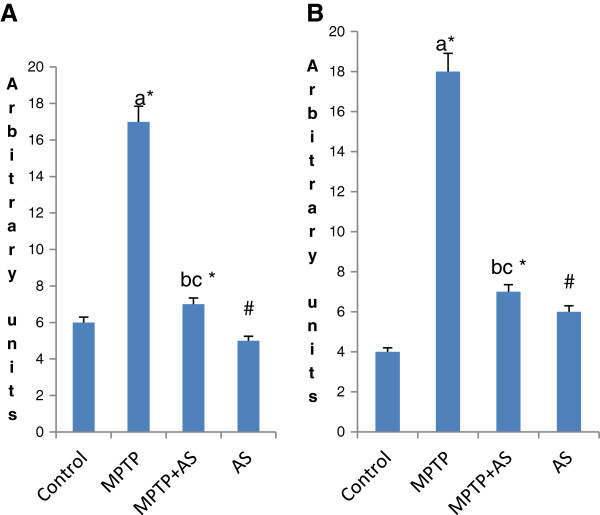
Each bar represented the mean ± S.D of 6 mice (n = 6). * represents statistical significant at P < 0.05. Comparasion were made as (a) group I vs group II, (b) group II Vs group III, (c) group I vs group III, (#) non significant group I vs group IV (scale bar 50 μm) A: Densitometric pattern of the expression of GFAP in striatum. B: Densitometric pattern of the expression of GFAP in midbrain.